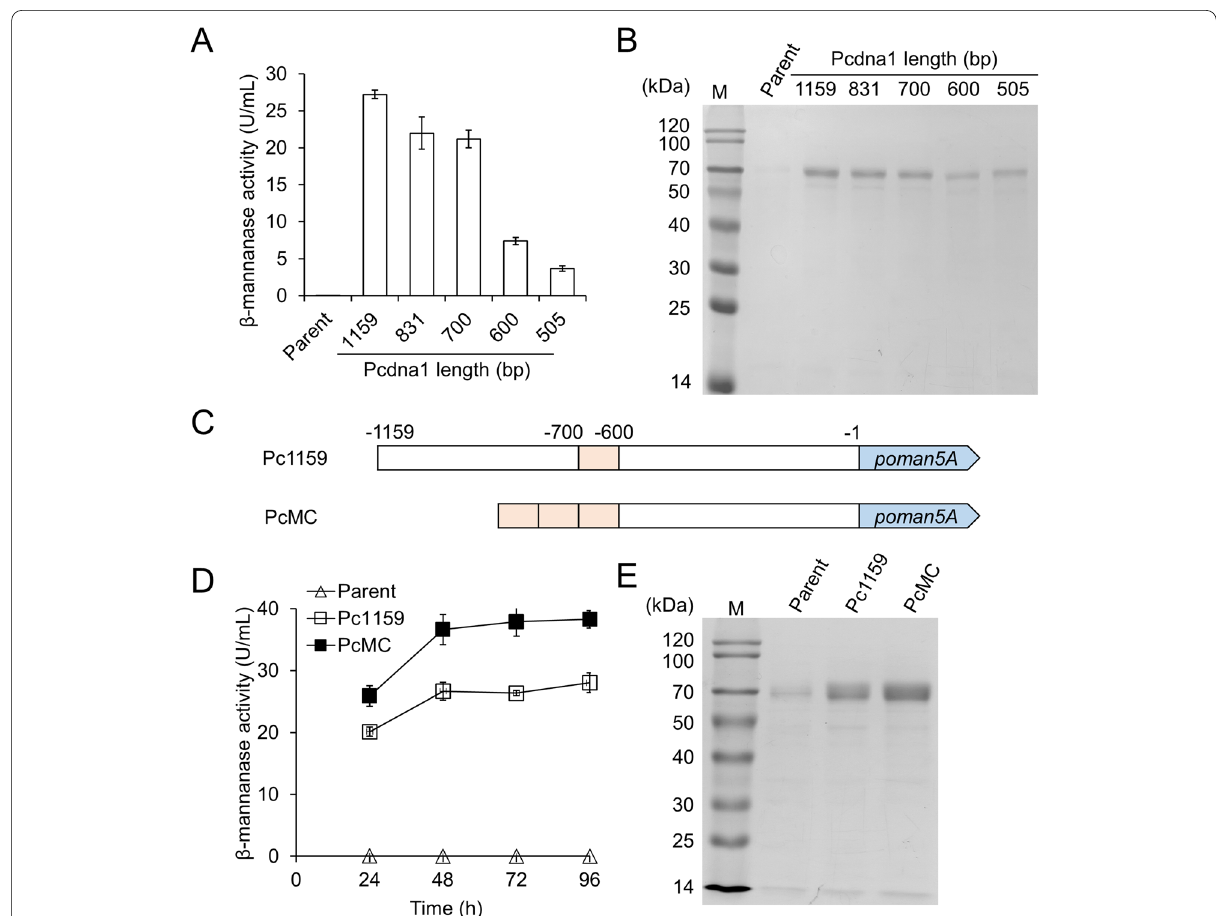
Fig. 1 Identification of the key sequence and engineering of cdna1 promoter. A Extracellular β-mannanase activities of strains expressing poman5A with different lengths of cdna1 promoter. The parent strain QP4 was used as a control. The samples were taken after 48 h of cultivation. B SDS-PAGE analysis of culture supernatants analyzed in panel A. C Schematic representation of the original (Pc1159) and engineered (PcMC) cdna1 promoter. D Extracellular β-mannanase activities of strains expressing poman5A with original and engineered cdna1 promoter. E SDS-PAGE analysis of the culture supernatants at 72 h analyzed in panel D . Data in panels A and D represent mean SD from triplicate ±